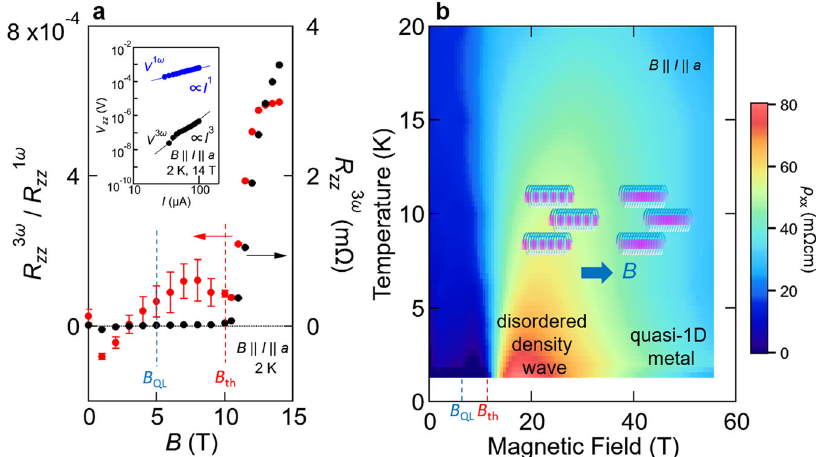
Fig. 4 Non-linear transport measurements. a The magnetic fi eld dependence of the third-harmonic resistance R zz 3 ω . Third-harmonic resistance normalized by linear resistance R zz 3 ω / R zz 1 ω is also plotted. Here, R zz 1 ω = V zz 1 ω / I and R zz 3 ω = − V zz 3 ω / I . The measurements were done under the condition of I = 75 uA and f = 2317 Hz to avoid the heating effects. The inset shows the current dependence of linear and third- harmonic voltage at a frequency of 2317 Hz at 2 K and 14 T. b The contour plot of resistivity as a function of temperature and magnetic fi eld in the longitudinal con fi guration ( B || I || a ). The inset shows schematic illustrations of the disordered density wave phase and quasi-1D metal